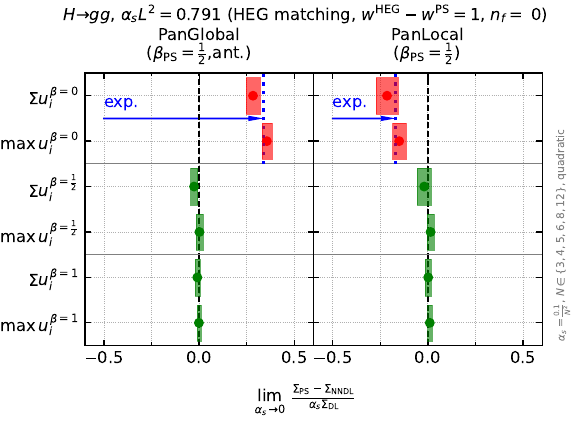
Figure 8. Results of NNDL accuracy tests with n f = 0 for the PanGlobal and PanLocal showers ( β = 1 ), using the same shower as both a HEG and for the subsequent parton showering steps, but ps 2 with different choices of the de-symmetrisation parameter in the gluon splitting function, w heg = 1 , and w ps = 0 respectively. The expected value of the NNDL discrepancy for β eqs. (3.20a)–(3.20b) is shown in dotted